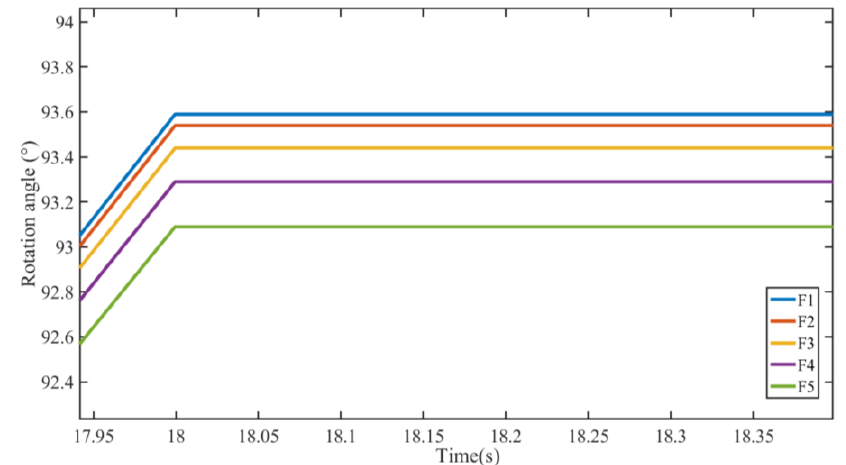
Figure 16. The rotation angle of leakage in speed regulating valve.